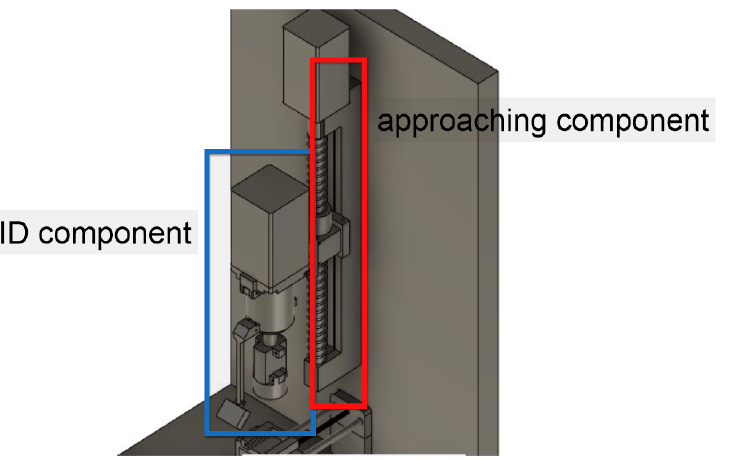
Figure 2. The model of the entire system. The approaching component and ID component are marked as rectangles and labeled with distinct